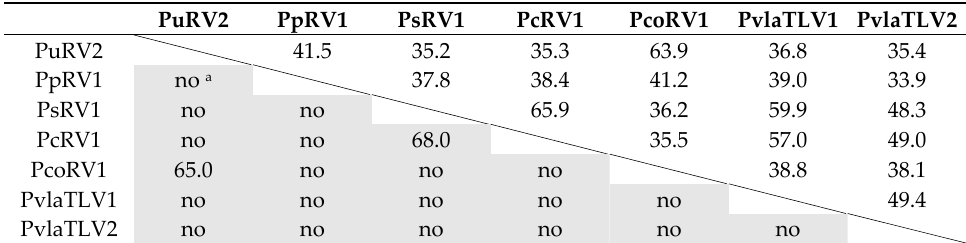
Table 2. Amino acid (white cells) and nucleotide (gray cells) sequence identities of RdRp_4 domain among toti-like oomycete viruses.